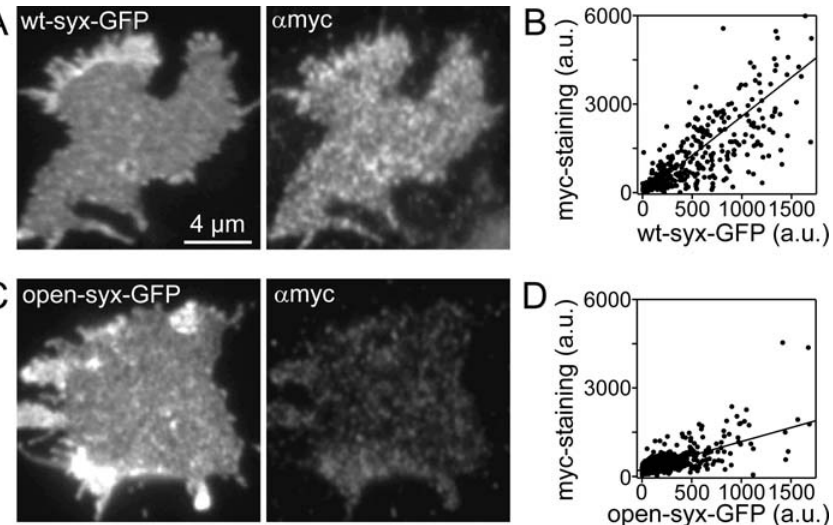
Figure 3. Munc18–1 Membrane Recruitment Requires the Closed Conformation of Syntaxin Co-overexpression of myc-tagged Munc18–1 together with GFP-tagged syntaxin 1 (A) and (B) or an open mutant of syntaxin 1 (C) and (D). Membrane- recruited overexpressd Munc18–1 was selectively visualized on the background of endogenous Munc18–1 by immunostaining for the myc-tag. For each condition, the level of overexpressed syntaxin and of overexpressed, recruited Munc18–1 were determined for individual membrane sheets, plotted against each other, and linearly fitted (B) and (D). The ratio of the slopes wild-type (wt) syntaxin:open syntaxin was determined to be 2.1. The graphs contain data points from 411 membrane sheets for wt syntaxin 1/Munc18–1 and 417 for open syntaxin 1/Munc18–1 obtained from ten independent experiments. DOI: 10.1371/journal.pbio.0040330.g003